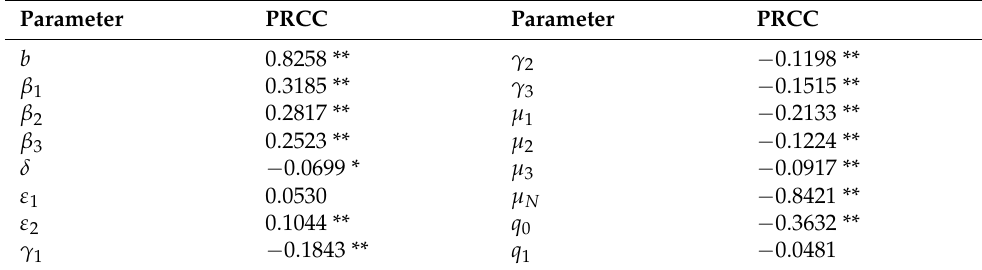
Table 2. Partial rank correlation